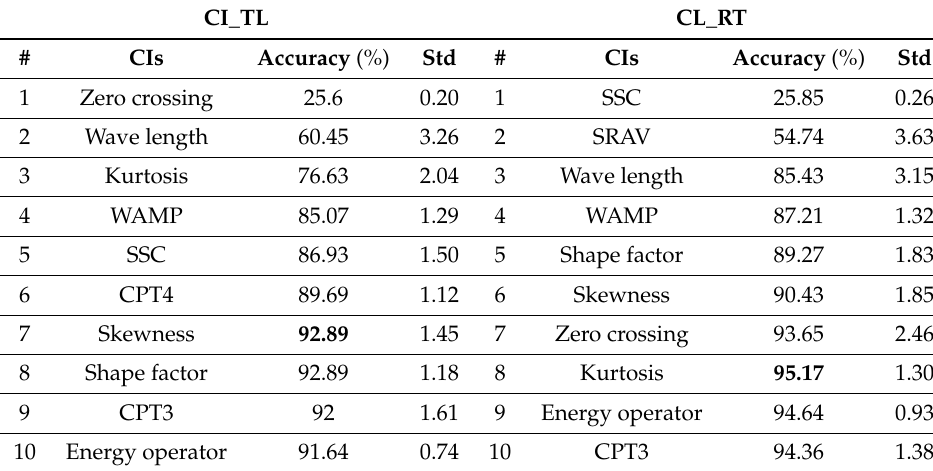
Table 3. Top 10 CIs and accuracies average over time domain.